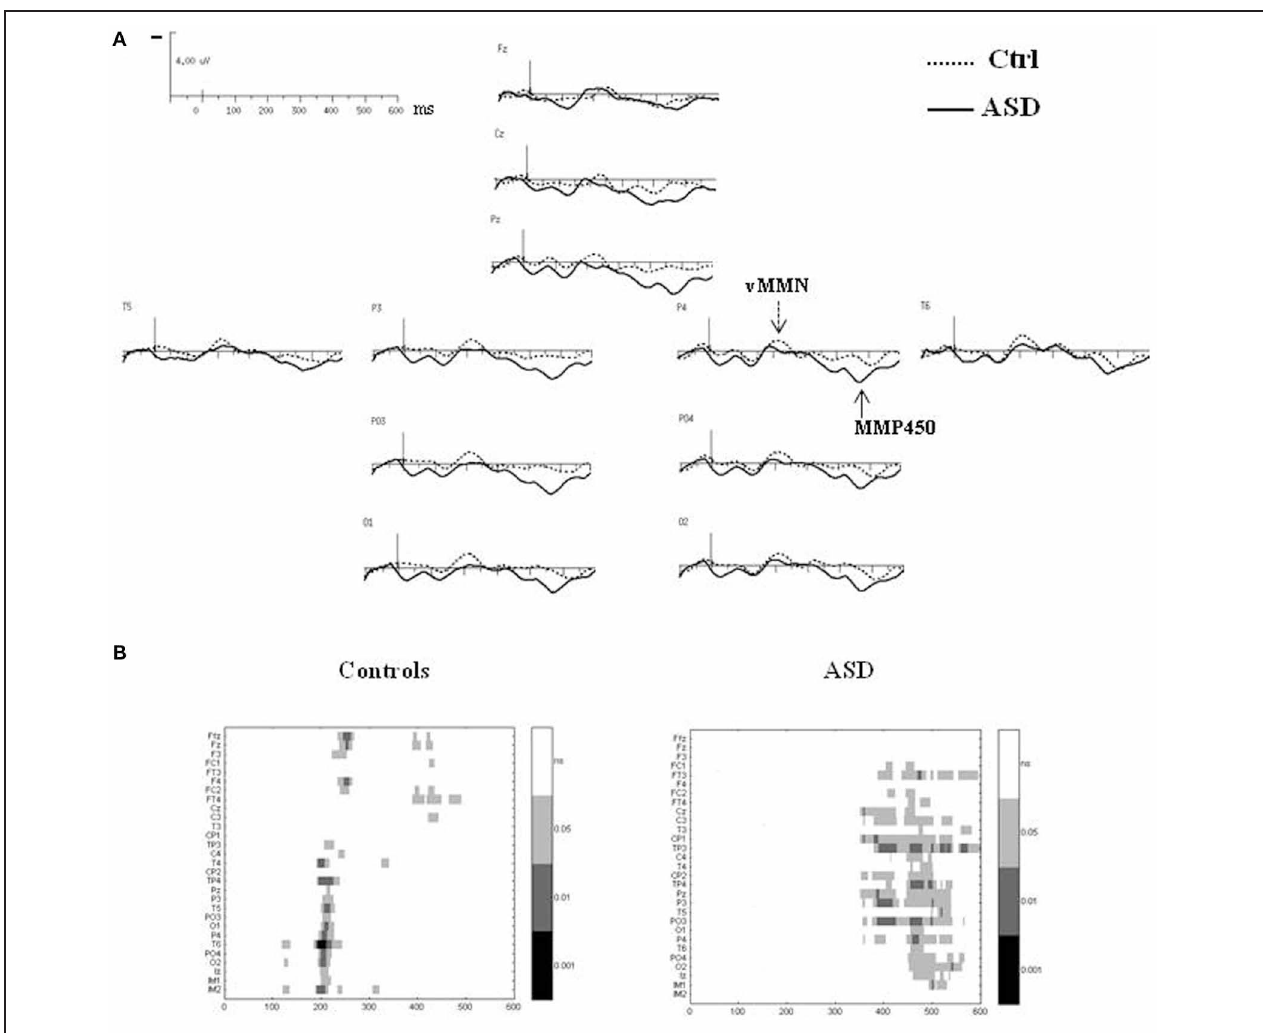
FIGURE 4 | (A) Grand-average difference waves obtained by subtracting the ERPs to the standard stimuli from those to the deviant stimuli in each group at selected electrodes. (B) Paired student t -test analysis